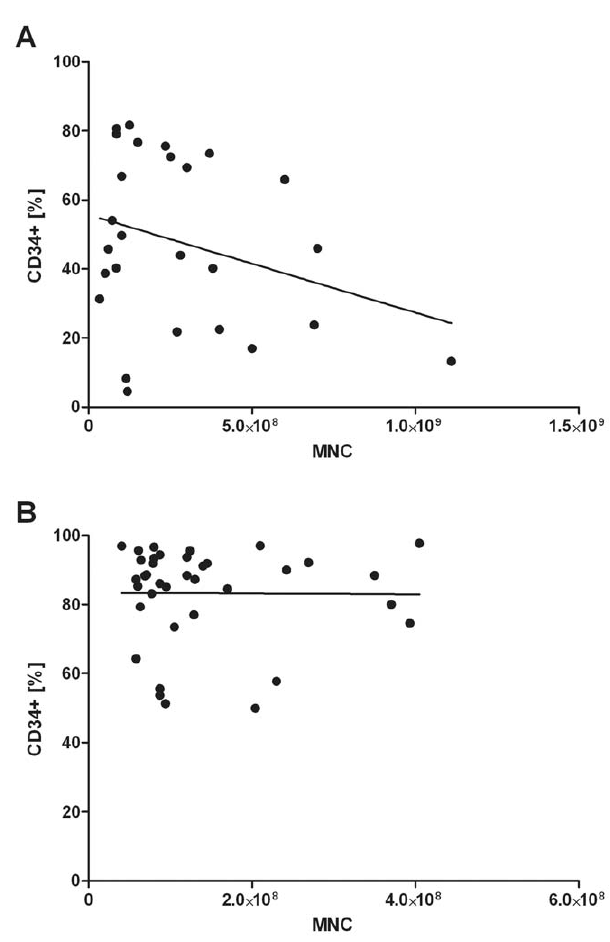
Figure 3. The purity of CD34 + separation decreases with an increasing number of MNC in CCB. MNC were isolated from CCB or FCB by washing with DNAse buffer or Ficoll-paque density gradient centrifugation as described in materials and methods. CD34 + stem cells were isolated from MNC by a positive magnetic separation of CD34 + cells and the purity was determined by flow cytometry. The correlations between the number of MNC and the purity of the CD34 + separation for CCB (A; no significance) and FCB (B) are shown. Correlations were evaluated using GraphPad Prism software and the Spearman rank correlation coefficient